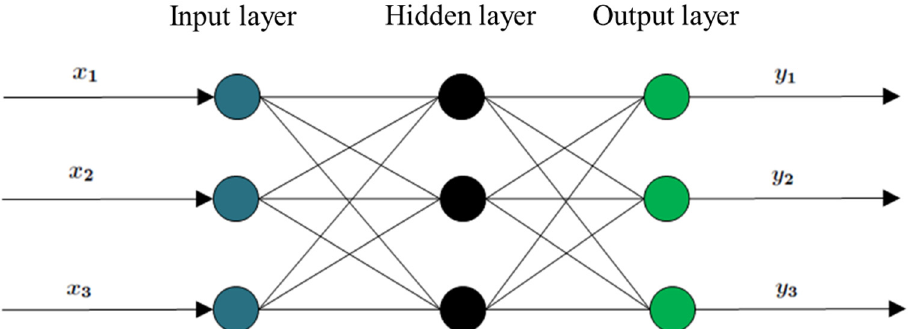
Figure 3. Schematic diagram of BP neural network.